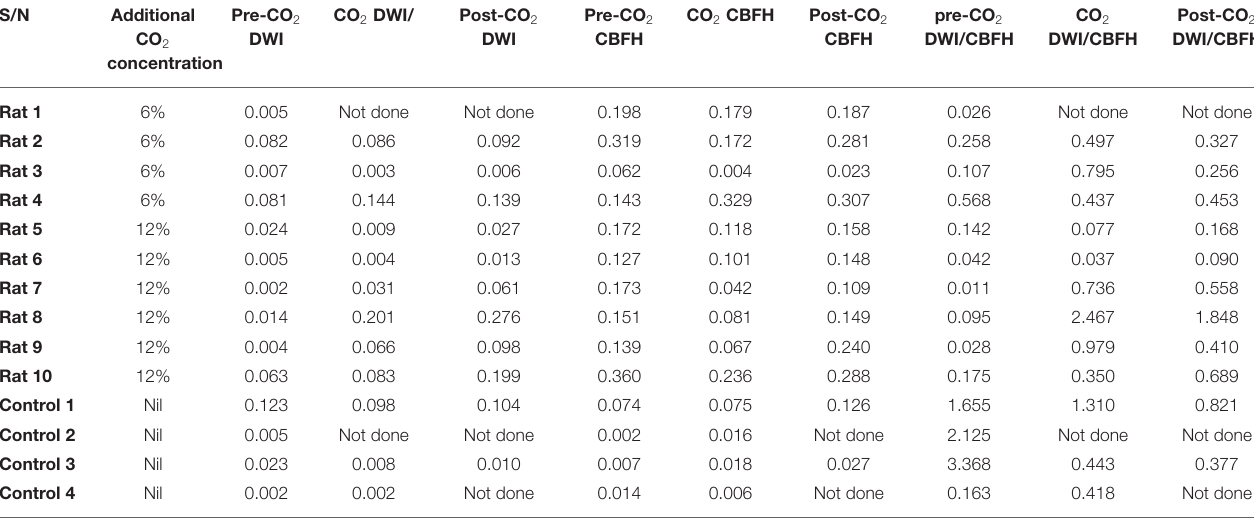
TABLE 1 | Ipsilateral ratio of diffusion weighted imaging (DWI) volume and arterial spin labeling hypoperfusion (CBHF) volume divided by ipsilateral hemispheric brain volume, at various time points and in the three